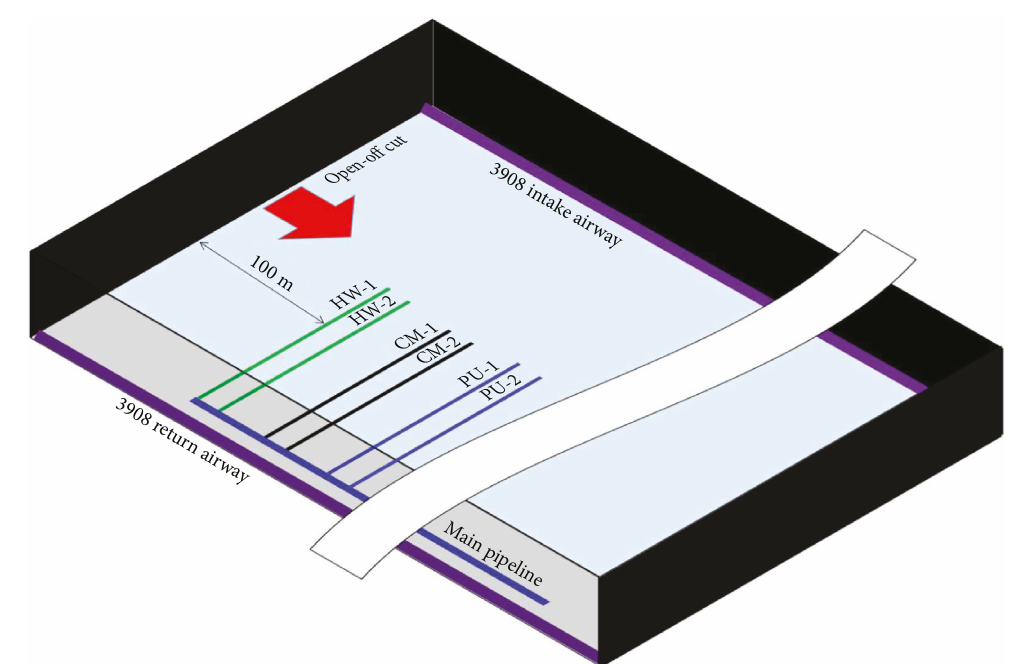
Figure 9: Borehole layout in the observation